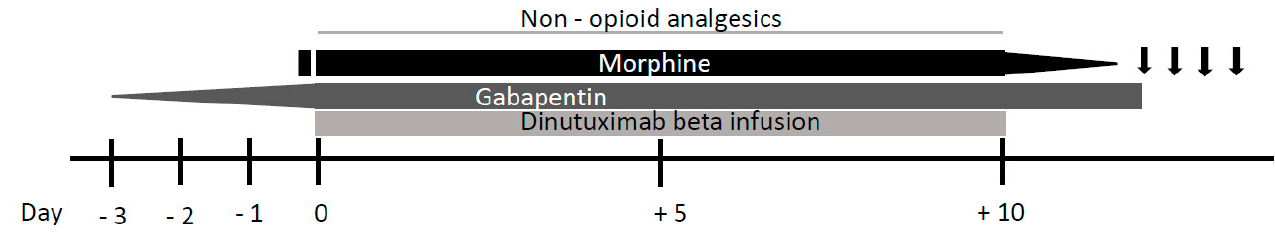
Figure 3. Neuropathic pain management during continuous dinutuximab beta infusion. Gabapentin administration is started three days prior to dinutuximab beta infusion and increased up to 10 mg/kg for three daily administrations. After a bolus, morphine is commenced just before dinutuximab beta infusion and continued as a 24 h intravenous infusion (0.03 mg/kg/h). Following reduction of its infusion rate, morphine is stopped 4 h after the end of dinutuximab beta infusion. If neuropathic pain persist after the intravenous morphine weaning off, oral morphine sulphate or tramadol can be admin- istered on demand.